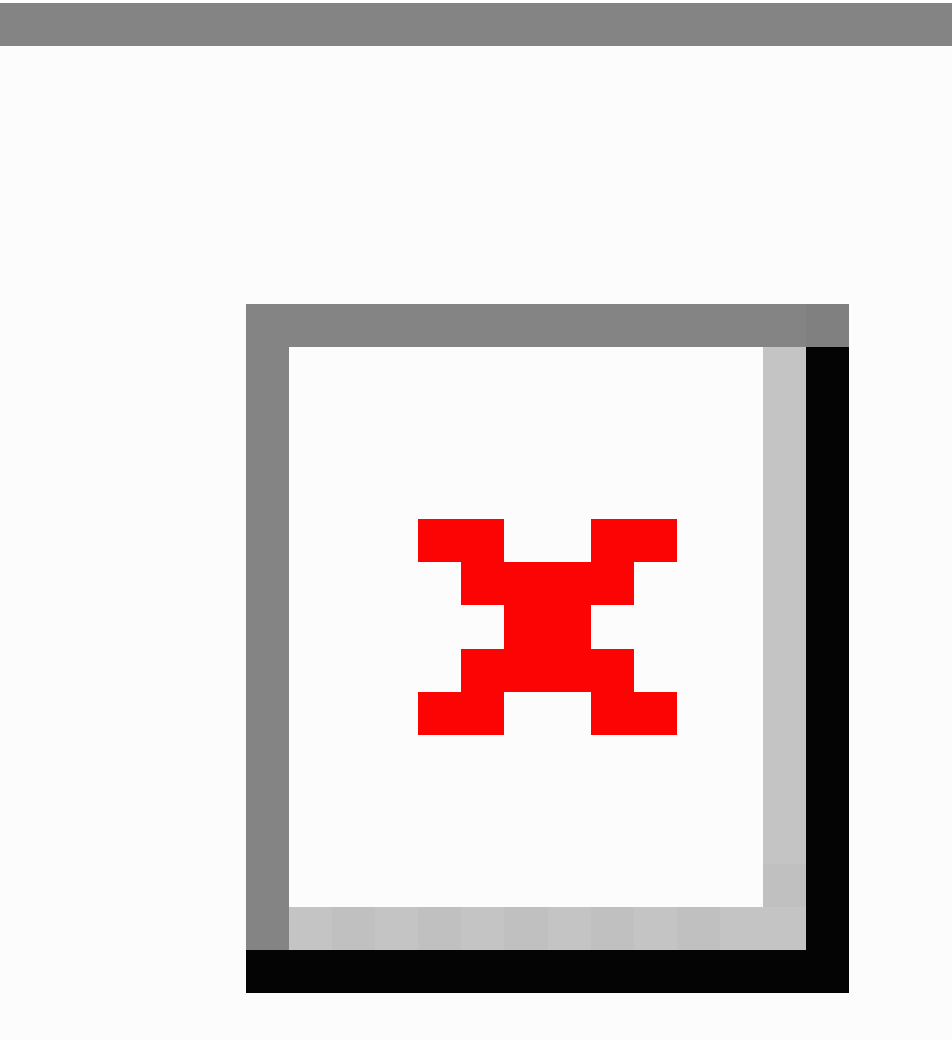
Figure 3. A graphical representation of the 30-second Chair Stand Test as captured by an iOS-based linear accelerometer. Y-axis features represent the postural transitions of sitting and standing and Z-axis features represent anterior and posterior movement during the postural transition. acc: